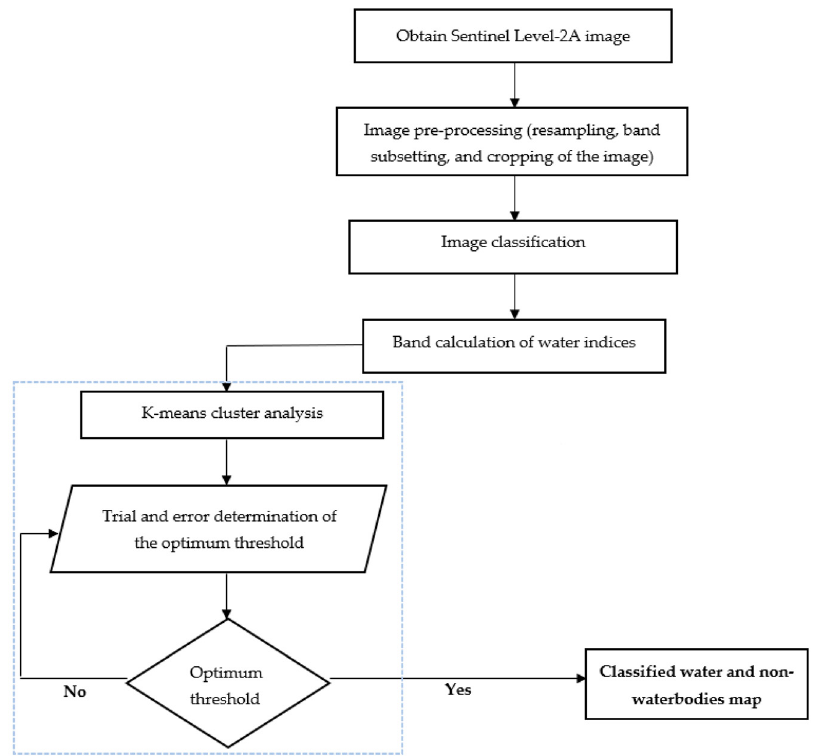
Figure 1. Workflow of the image classification exercise. The blue rectangle highlights the activities involved in identifying the optimum thresholds for the various water indices. Index values obtained from band calculations were grouped using k-means cluster analysis. The cluster centers were compared for accuracy using a trial and error method The cluster centroid(s) that gave the highest overall accuracy and kappa was selected as the optimum threshold for that particular water index. These were then employed in the binary classification of water and non-water.